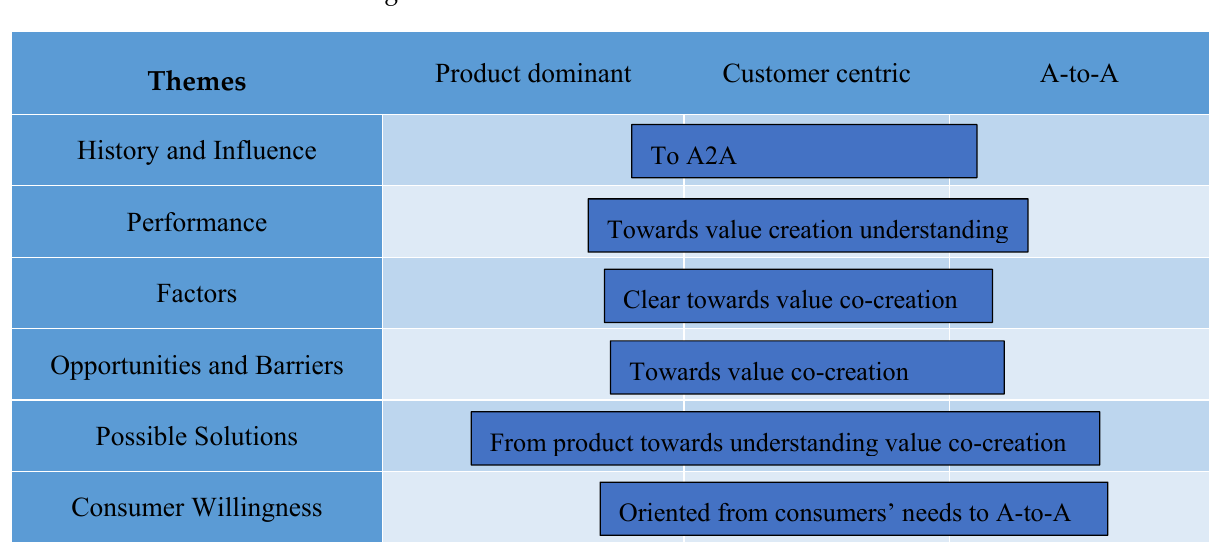
Figure 3. Logic of value creation.